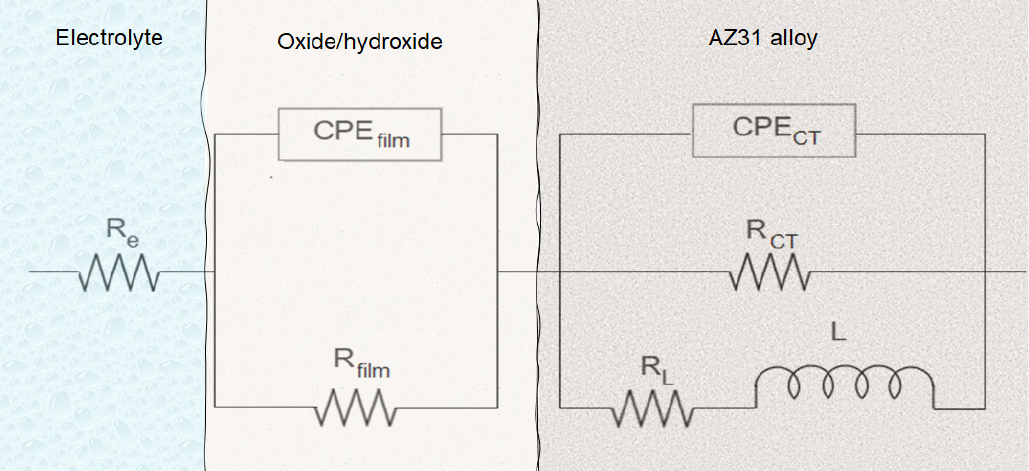
Figure 9. Proposed equivalent circuit and physical model representing the impedance responses of samples AZ and AZ + Ar-P after exposure in 0.1 M Na 2 SO 4 solution.